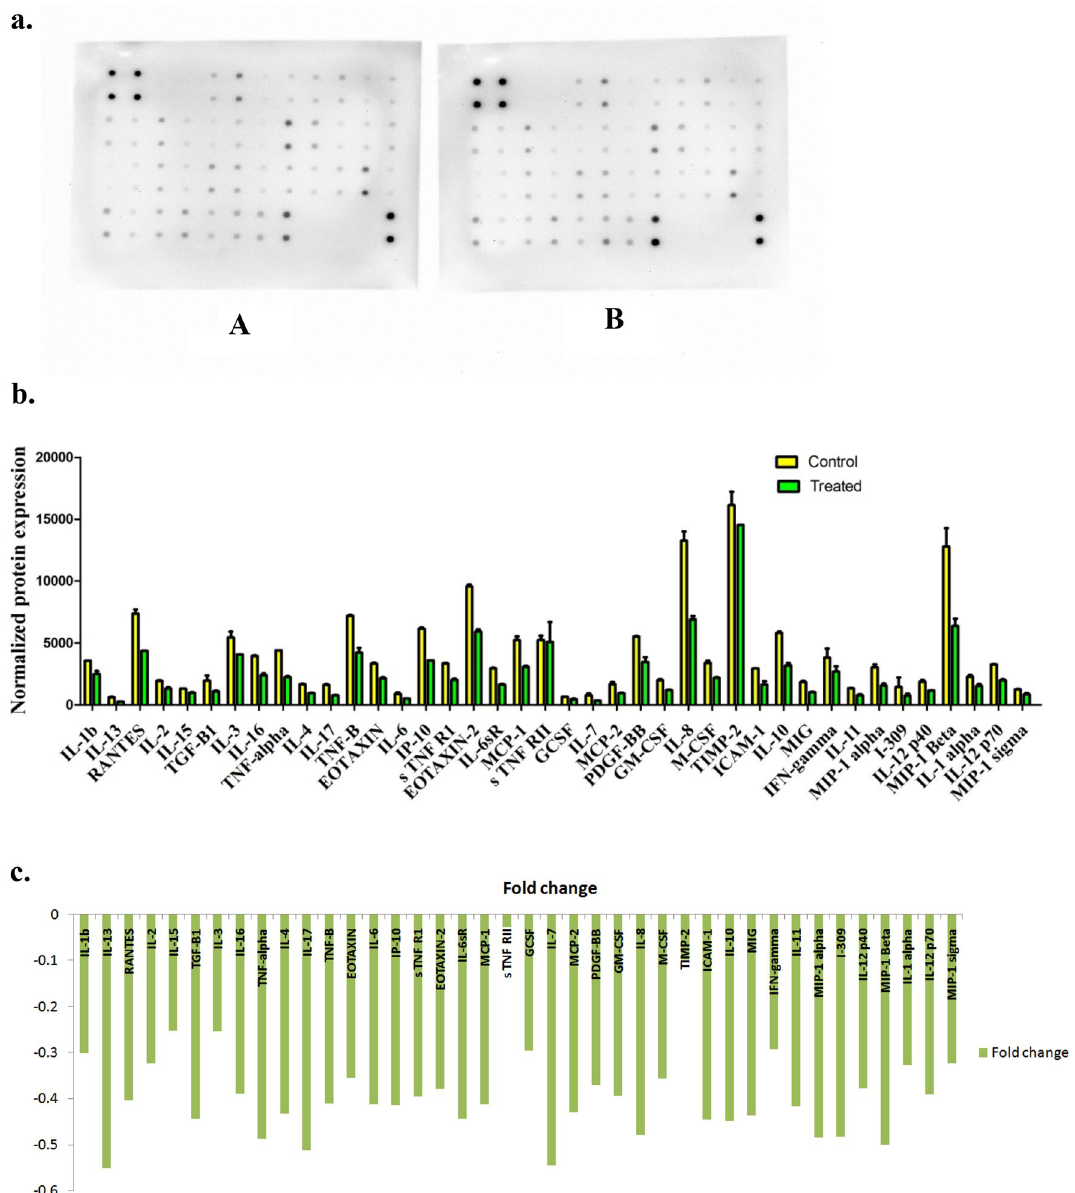
Figure 4. The inhibitory effect of 1 mM melatonin on the inflammation. a . Human inflammation antibody array membranes detect signal spots of 40 targets / membrane. ( A ) The array membrane of vehicle control (DMSO treated) HepG2 cells, ( B ) The array membrane of 1 mM melatonin-treated HepG2 cells for 24 h. After development of the membranes, the imaging of the spots signals’ was detected by Chemiluminescence using CCD camera of chemiluminescence imager (UVP, UK), and the raw densitometry data was measured with the Image Studio Lite software, (https:// www. licor. com/), b. The anti-inflammatory effect of 1 mM melatonin. The graph shows the effect of 1 mM melatonin for 24 h on the mean expression levels of normalized inflammatory mediators in HepG2 cells, in a comparison to the control untreated cells. After subtracting the background signals, each spot was normalized to the positive control before comparing analyte-by-analyte to determine relative differences in inflammatory factors expression for each sample. All cytokines were expressed in non- significant varied lower levels as compared to control untreated HepG2 cells. The data were calculated as a mean of duplicate ± SEM, and c. the calculated fold changes (of 40 inflammatory factors expressed in 1 mM melatonin-treated HCC-HepG2 cells after incubation time of 24 h) to control. The chart displays the decreasing of the expression levels of all detected inflammatory mediators with the lowest expression levels were calculated for interleukin (IL)-7, and